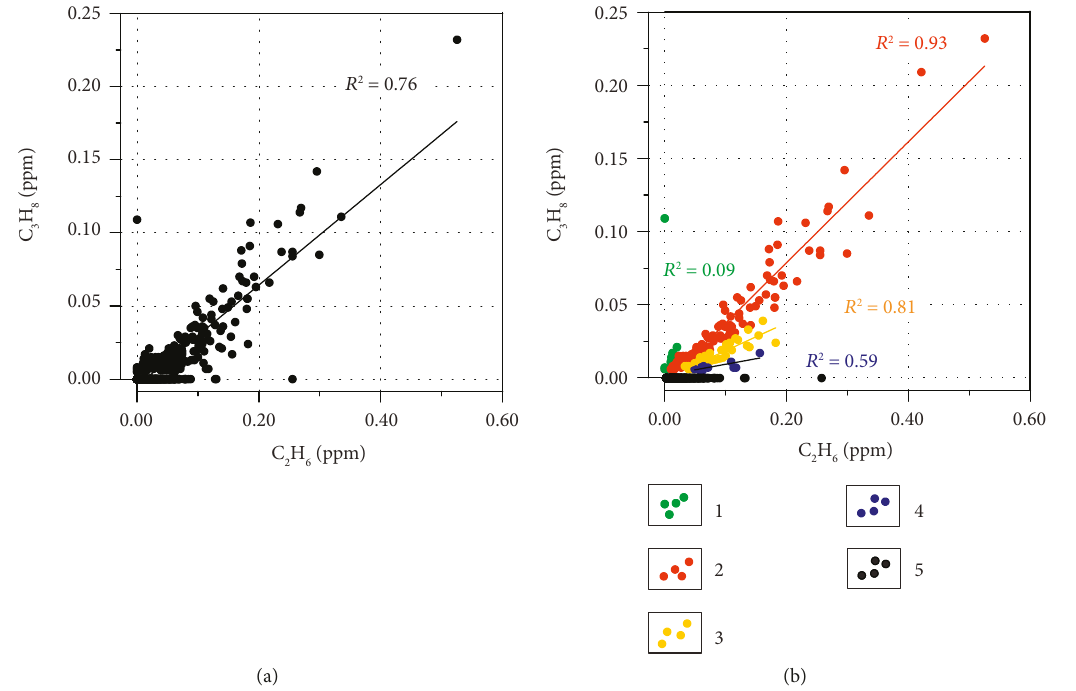
Figure 6: Scatter plots of ethane versus propane concentrations for the whole dataset (a) and for the following subsets (b): 1 — C 2 — C /C , from 1.5 to 4.0; 3 — C 2 3